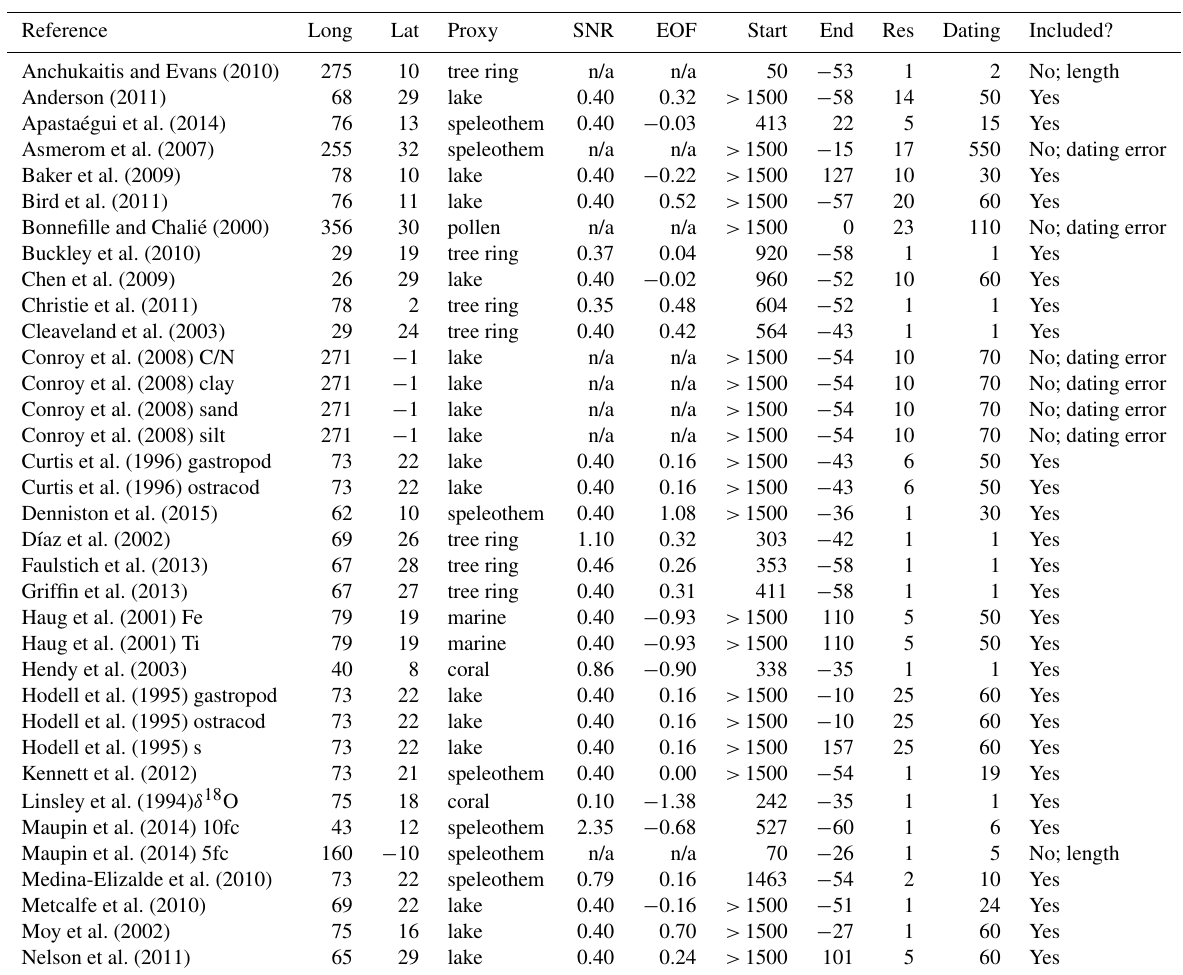
Table A1. Precipitation proxy details. “SNR” gives the signal-to-noise ratio used to make the pseudo-proxies. “EOF” gives the (unscaled) 20CRV2c EOF value used to weight the proxy. “Start” and “End” are starting and ending years in years BP. “Res” is proxy resolution, rounded to the nearest integer; sub-annual proxies are listed as having a 1-year resolution. “Dating” refers to dating error. “Included?” indicates whether the proxy contributed to the final ENSO reconstruction; if not, the reason for exclusion is listed (“Dating error” and “Length” are a priori conditions, which the proxies failed to meet. “AOI” indicates that it passed preprocessing screening, but was not selected during the add-one-in